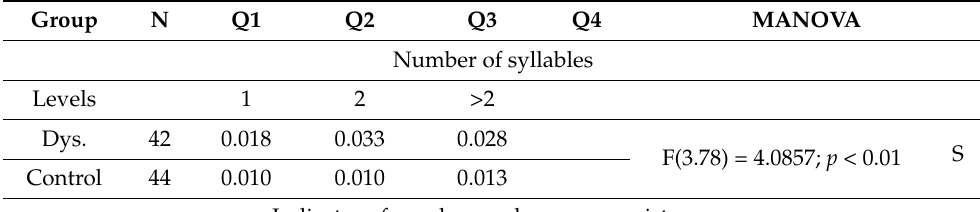
Table 5. Average number of errors (with respect to (w.r.t.) text length) according to 4 levels of each indicator of